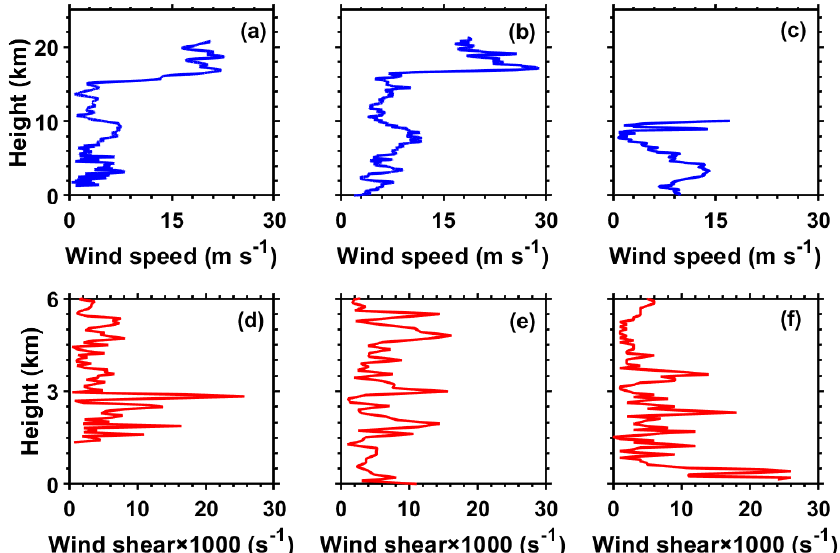
Figure 5. The profiles of wind speed ( a – c ) and local vertical wind shear ( d – f ) from two − way rawinsonde and dropsonde measurements for three different evolutionary stages of Typhoon Sinlaku: pre-TD ( a , d ), TD ( b , e ), and TS ( c , f ).